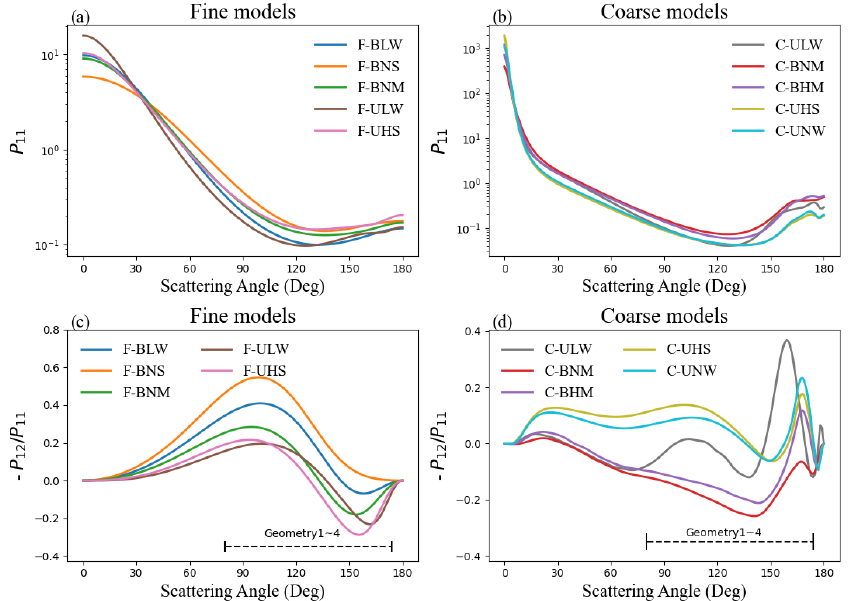
Figure 3. Scattering phase functions ( a , b ) and polarized phase functions ( c , d ) of ten typical aerosol models at a wavelength of 388 nm. ( a , c ) represents fine mode aerosol types and ( b , d ) represents coarse mode aerosol types.